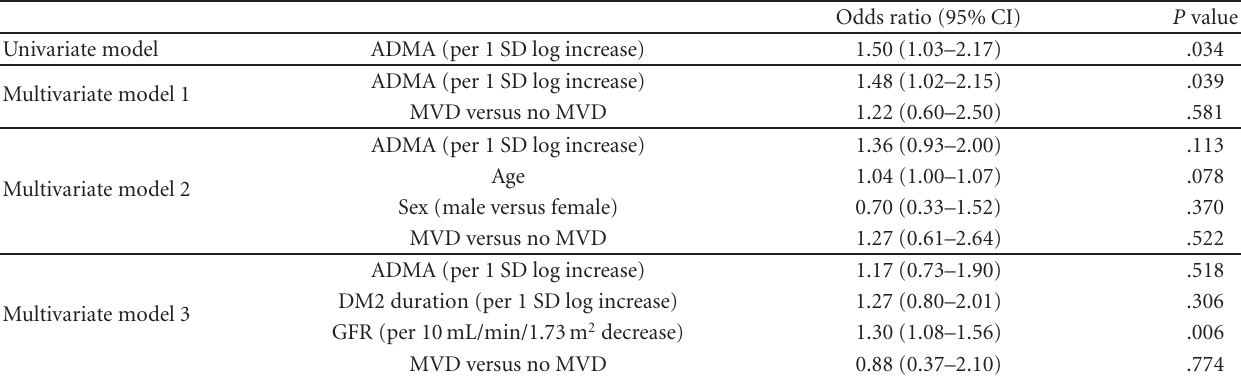
Table 3: Univariate and multivariate logistic regression analysis including diabetic retinopathy as dependent variable and asymmetric dimethylarginine (ADMA) and possible confounders as independent variables.